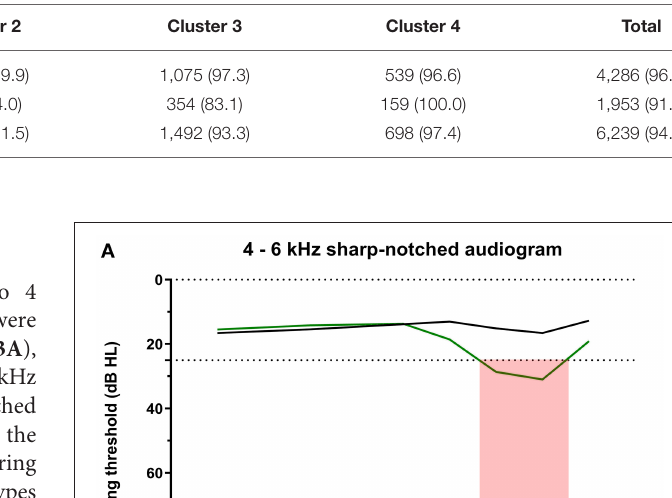
of audiometric phenotypes stratified by confounding factors (sex, age, CNE, HPD use, hearing difficulty, tinnitus, tobacco consumption, and alcohol consumption). According